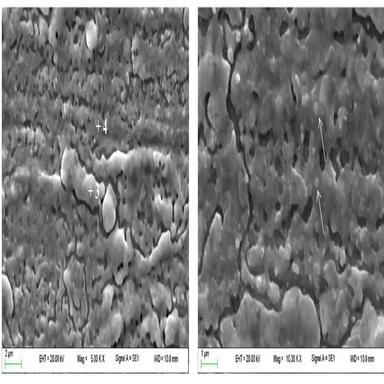
Surface morphology of the samples, a) Oxidized (1000×), b) Oxidized (5000×), c) oxidized-reduced (5000×), d) oxidized-reduced (10,000×).